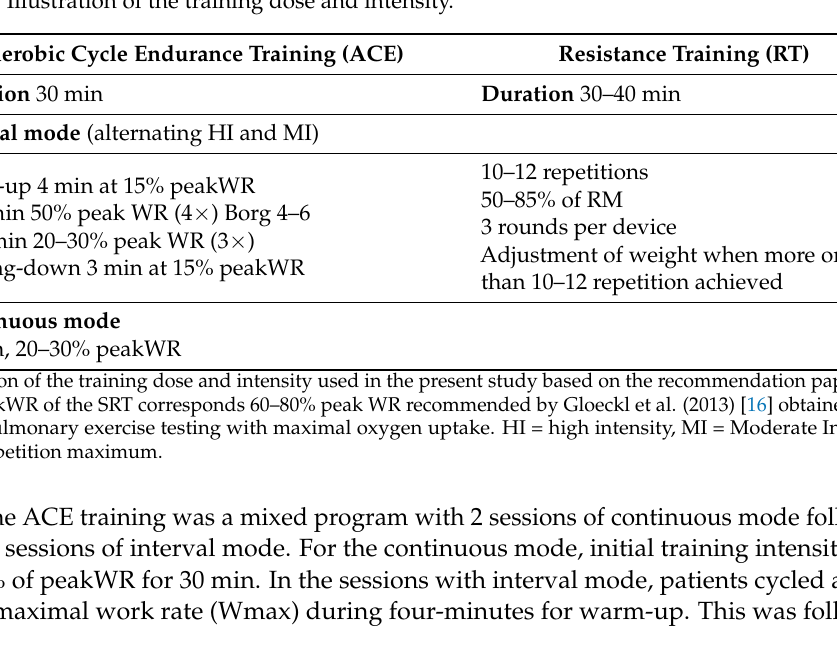
Table 1. Illustration of the training dose and